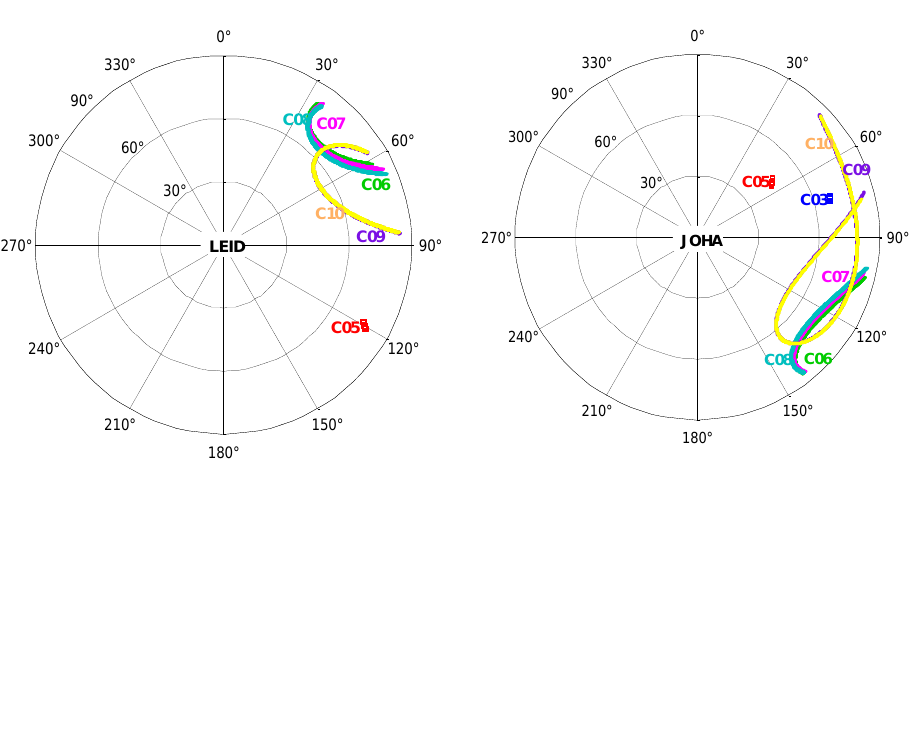
Figure 7. Sky plot of tracked satellites at four particular stations, LEID (51.9°, 44.0°), JOHA (−25.8°, 27.9°), DHAB (24.2°, 54.5°), and SHAO (121.5°, 30.9°) on day 171 in 2012. It is denoted by azimuth and zenith for four GEOs: C01, C03, C04, C05 and five IGSOs: C06, C07, C08, C09, C10. For some of the overseas stations, satellites can only